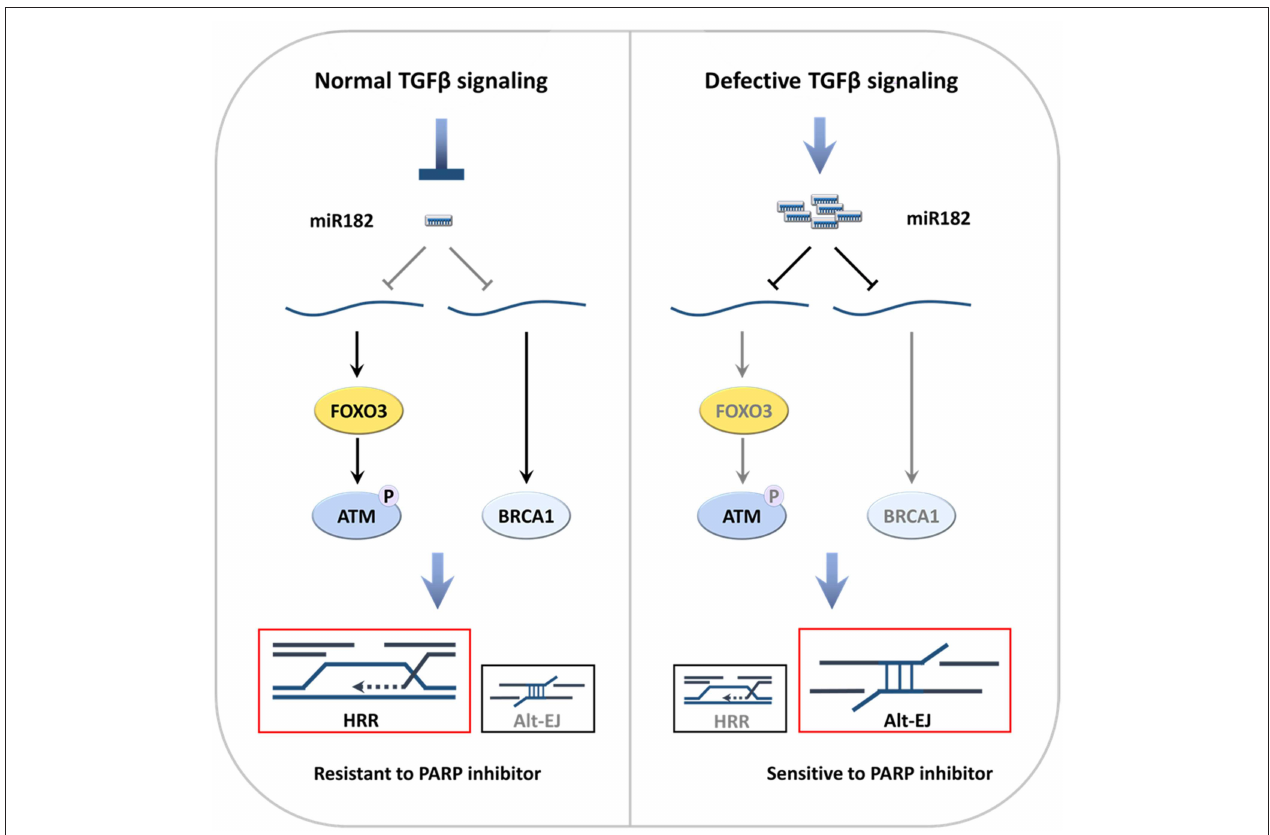
FIGURE 2 | Defective TGF β signaling in HNSCC increases altEJ (52). (A) TGF β signaling suppresses miR182, which suppresses expression of BRCA1 and FOXO3 . DNA damage elicits activates ATM autophosphorylation and its phosphorylation of BRCA1, which gives rise to use of HRR in S-phase. (B) In contrast, deficient TGF β signaling, which can be caused by HPV infection, TGF β receptor kinase inhibitors (TBRi) or SMAD4 mutations ( SMAD4 mut), leads to increased miR182 that suppresses BRCA1 and FOXO3 . Loss of FOXO3 inhibits ATM auto-activation, which together with decreased BRCA1, impedes HRR. This is accompanied by increased